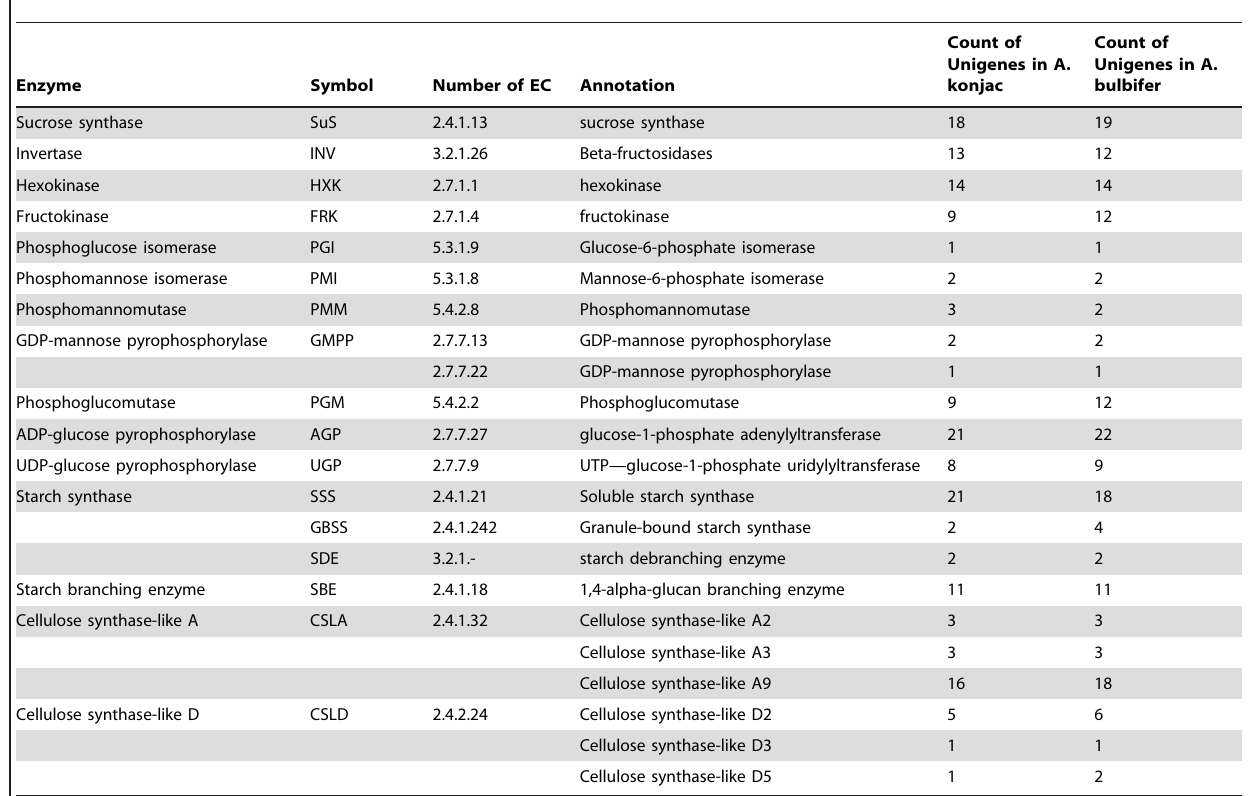
Table 5. Statistics of Glucomannan and starch biosynthesis related genes in Amorphophallus.